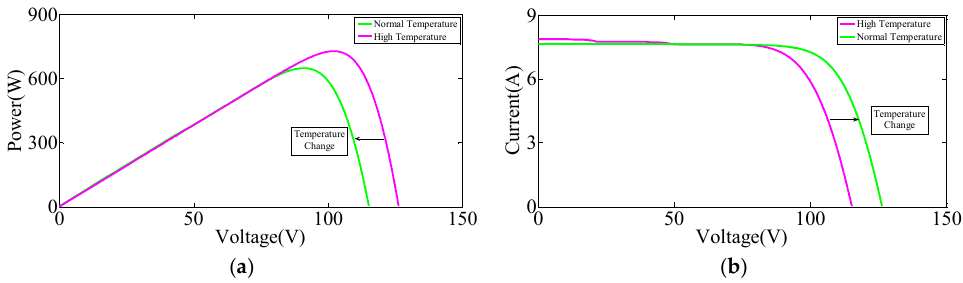
Figure 13. The output characteristics of the PV array for variable temperature conditions ( a ) P-V curve; ( b ) I-V